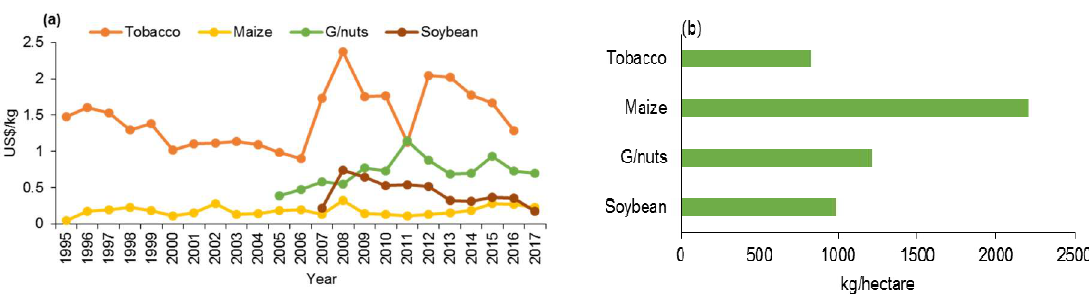
Figure 9. ( a ) Average annual prices of burley tobacco, maize, G/nuts (groundnuts), and soybeans per kilogram; ( b ) average yield in kilograms per hectare of soybeans, G/nuts, maize, and tobacco. Data source: TCCM, ADMARC, World Bank, and NASFAM.